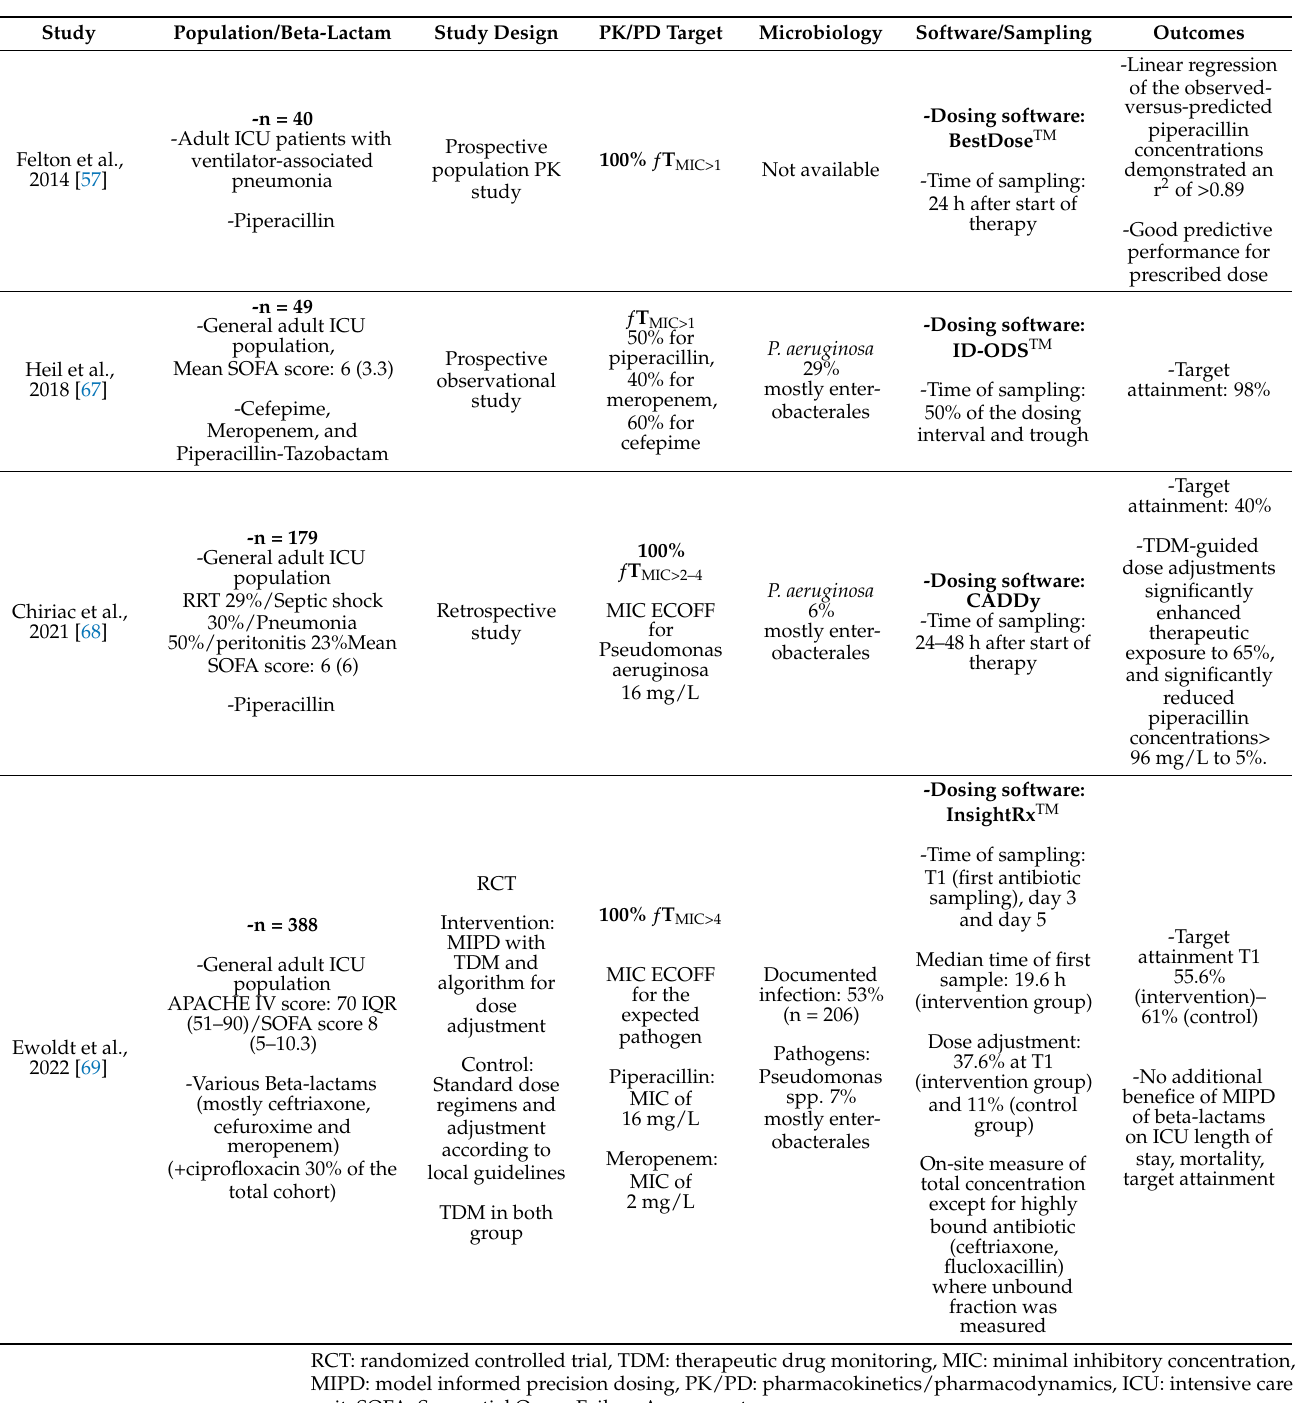
Table 3. Characteristics of the four clinical trials reporting BL dosing software clinical performance in critically ill